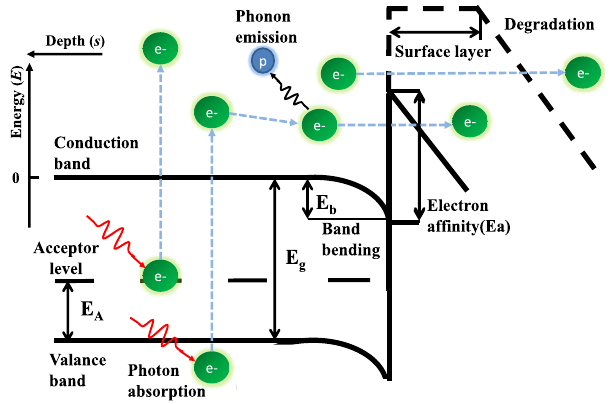
FIG. 1. Photoemission of semiconductors. The dash part at the surface side is the proposed model for